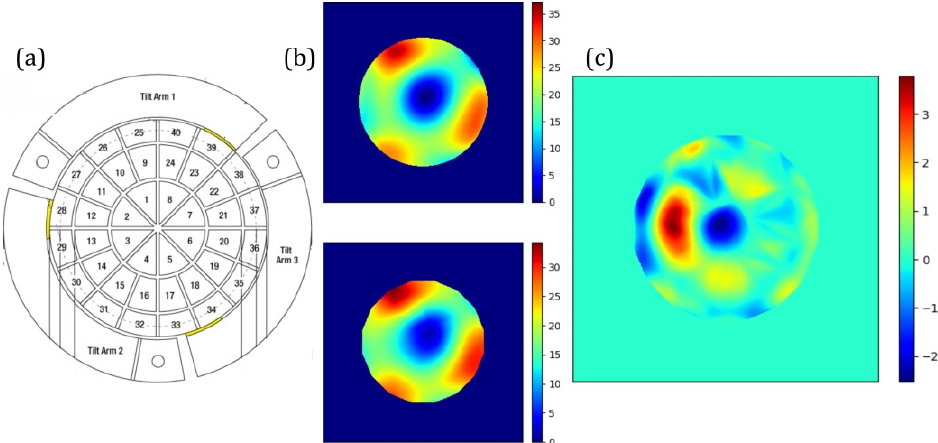
Figure 3. Piezoelectric mirror modeling. ( a ) Mirror actuators (according to the documentation from the manufacturer’s website); ( b ) initial phase and phase of the mirror obtained by simulation; ( c ) difference between the phases from Figure ( b ). Color bars are in radians.